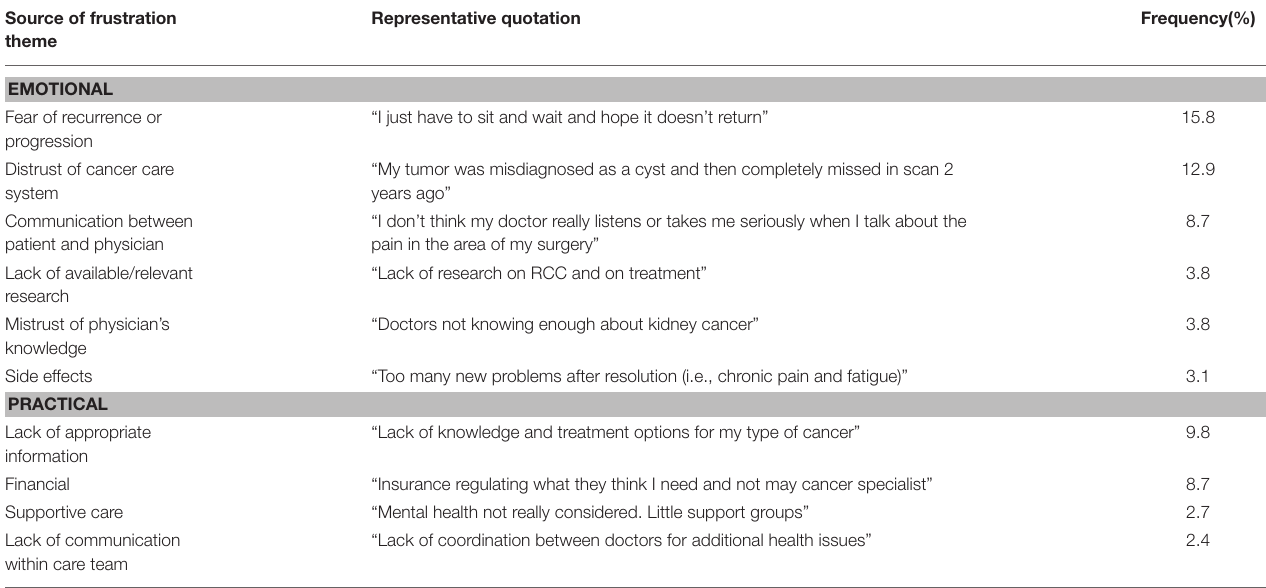
TABLE 1 | Sources of frustration cited by survey respondents with RCC with semi-qualitative characterization of responses.